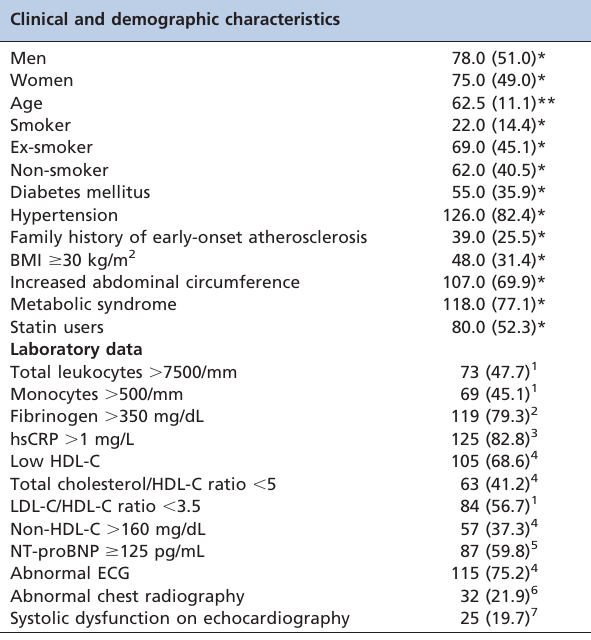
Table 1 - Descriptive analysis of the sample group.